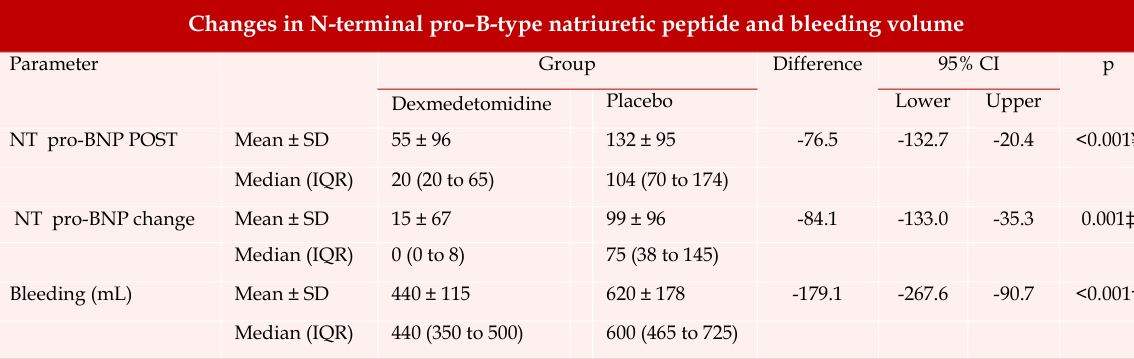
Changes in N-terminal pro – B-type natriuretic peptide and bleeding volume